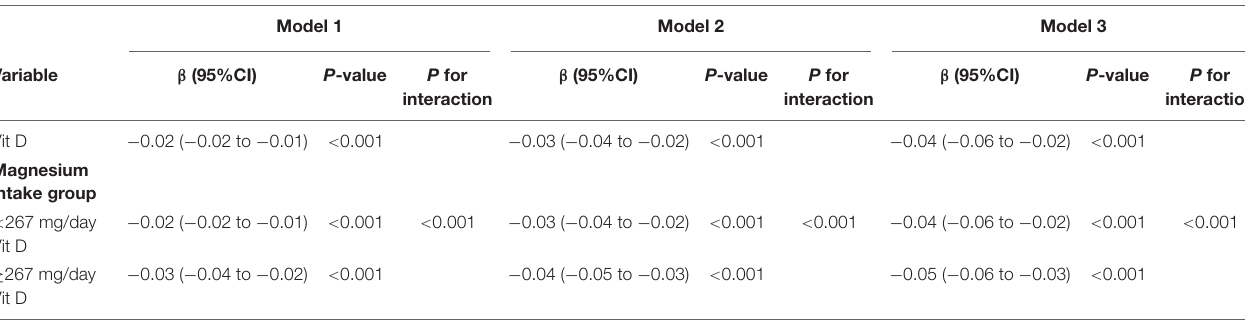
TABLE 4 | Interactive effect of vitamin D and dietary magnesium intake on HOMA-IR (All